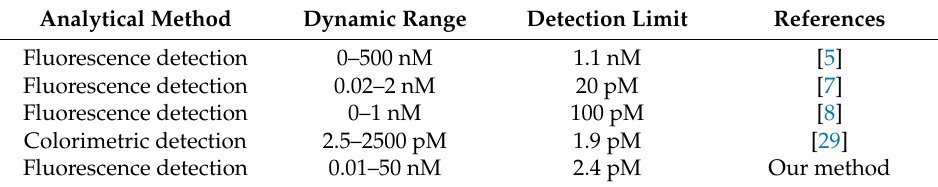
Figure 9. Results obtained from the fluorescent tests of Tris–HCl buffer and diluted serum samples spiked with different concentrations of thrombin. The same reaction mixtures without thrombin were used as blank. Error bars show the standard deviation of three experiments.